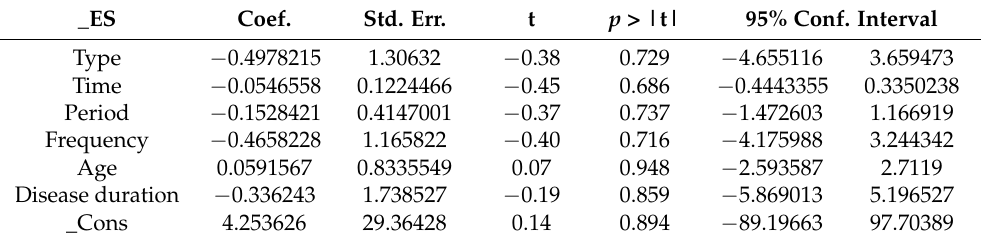
Table 2. Regression analysis of covariate for PD patients with depression.